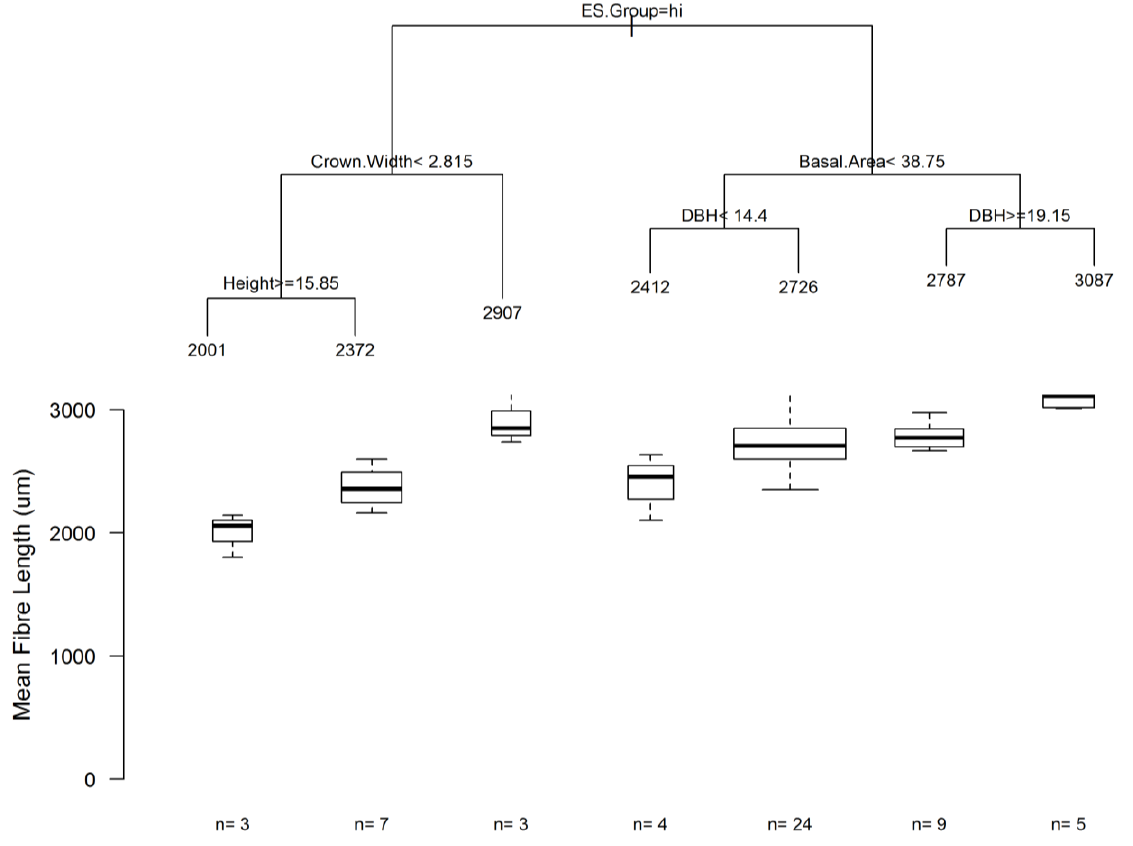
Figure 4. Regression tree analysis of area-weighted stem level mean fibre length of black spruce using site, tree and stand level variables for a sample population collected in northeastern Ontario, Canada. ES. Group is ecosite group (a = EG-2, Dry Sandy Ecosites; b = EG-3, Fresh Sandy or Dry to Fresh Coarse Loamy Ecosites; c = EG-4, Moist Sandy to Coarse Loamy Ecosites; d = EG-5, Fresh Clayey Ecosites; e = EG-6, Fresh Silty to Fine Loamy Ecosites; f = EG-7, Moist Silty to Fine Loamy to Clayey Ecosites; g = EG-8i, Intermediate Conifer Swamps; h = EG-8r, Rich Conifer Swamps and i = EG-8p, Poor Conifer Swamps). Variable definitions Basal Area = stand basal area (m 2 ·ha −1 ), Height = tree height (m), DBH = diameter at breast height (cm) and Crown Width = crown width in (m). If a condition is met on the dendrogram, the path to the left is